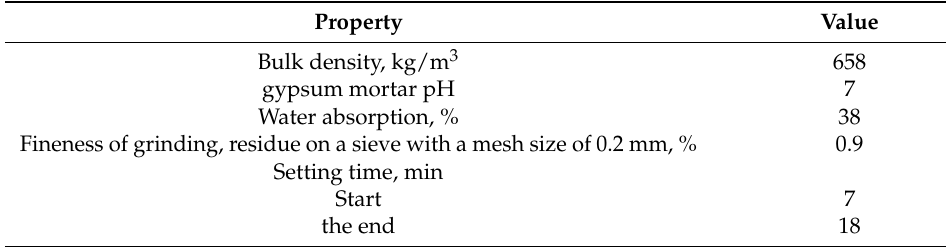
Table 6. Characteristics of gypsum G-6 B III.